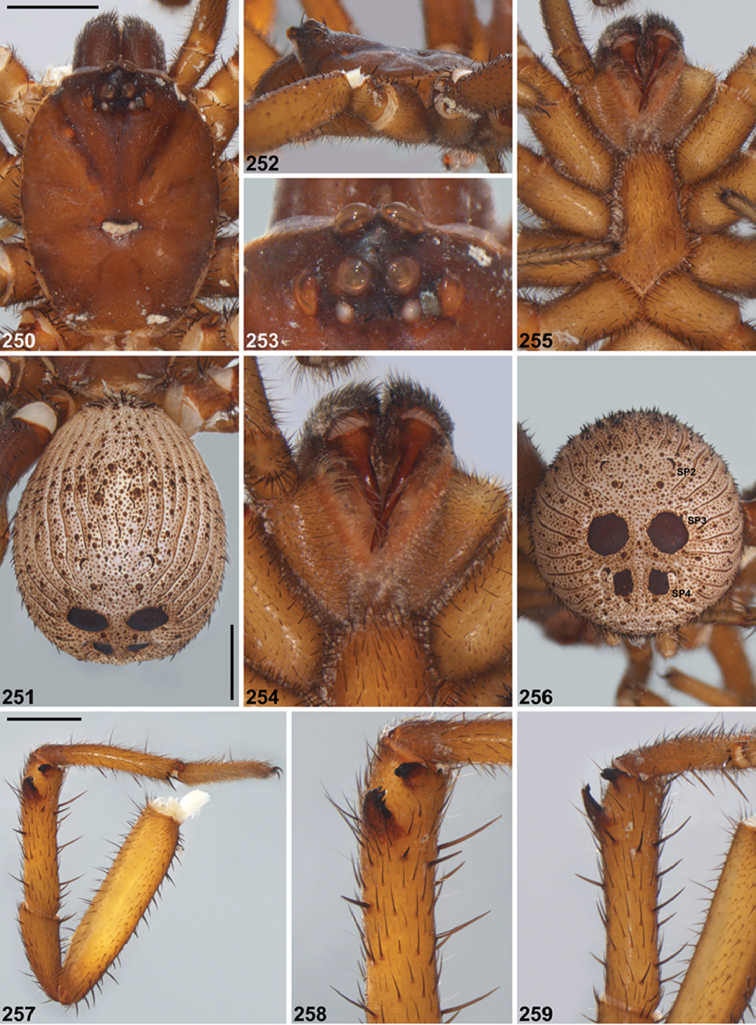

Idiosoma
kopejtkaorum sp. n., male holotype (WAM T144621) from Snake Gully Nature Reserve (Western Australia; AVW), somatic morphology. 250–251 Carapace and abdomen, dorsal view 252 Carapace, lateral view 253 Eyes, dorsal view 254 Mouthparts, ventral view 255 Sternum, ventral view 256 Abdomen, posterior view 257 Leg I, prolateral view 258 Leg I tibia, clasping spurs, prolateral view 259 Leg I tibia, proventral view. Scale bars 2.0. SP2–4 = sigilla pairs 2–4.